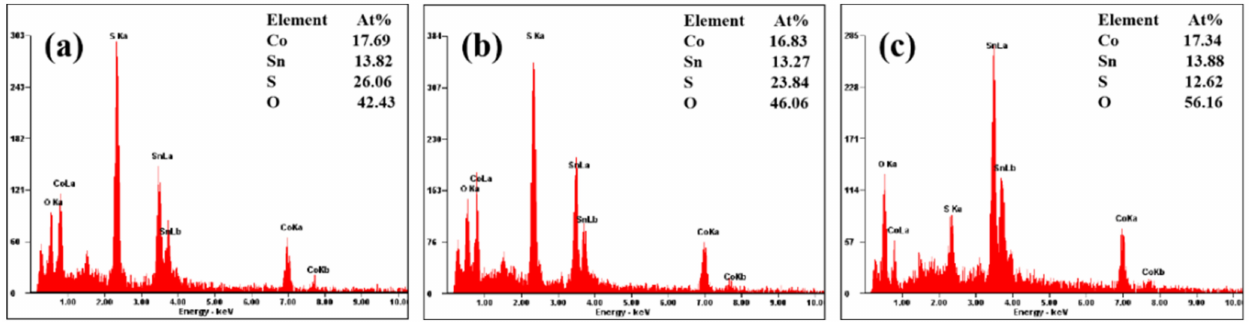
Figure 7. ( a ) EDS of Co 3 Sn 2 S 2 nanocrystals annealed at 450 ◦ C; ( b ) EDS of Co 3 Sn 2 S 2 nanocrystals annealed at 550 ◦ C; ( c ) EDS of Co 3 Sn 2 S 2 nanocrystals annealed at 650 ◦